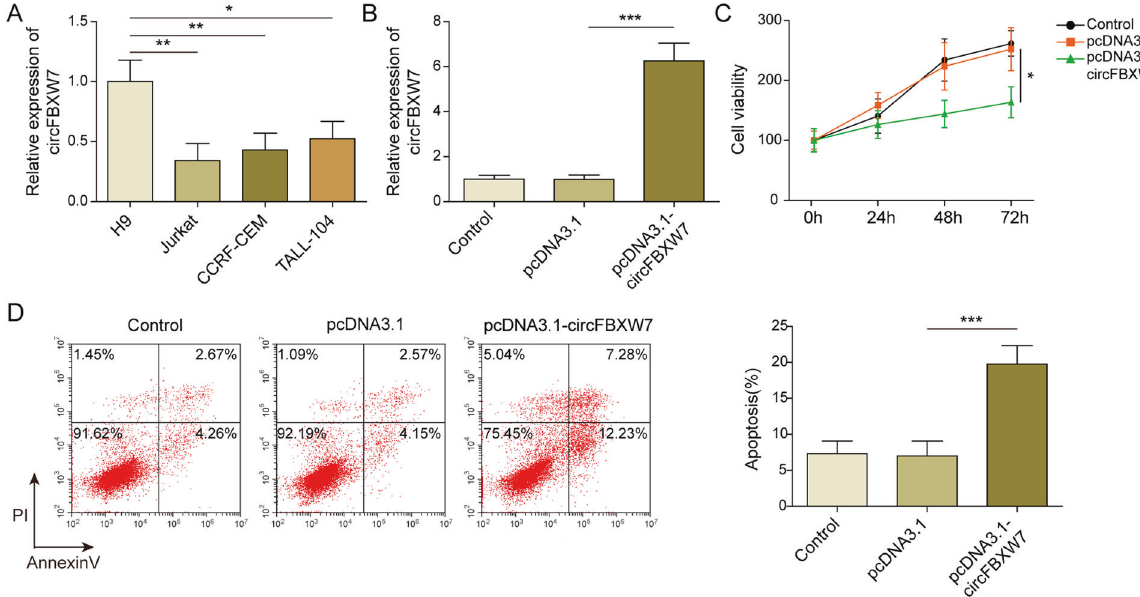
Fig. 1 Overexpression of circFBXW7 inhibited the proliferation of Jurkat cells via inducing apoptosis. A RT-qPCR analysis showed that the expression of circFBXW7 in T-ALL cells was signi fi cantly lower, compared to that in H9 cells. B RT-qPCR analysis revealed that pcDNA3.1 or pcDNA3.1-circFBXW7 was stably transfected into Jurkat cells. C , D MTT and fl ow cytometry determination showed that overexpression of circFBXW7 inhibited the proliferation and induced the apoptosis of Jurkat cells. The quantitative values are expressed as a mean ± SD from